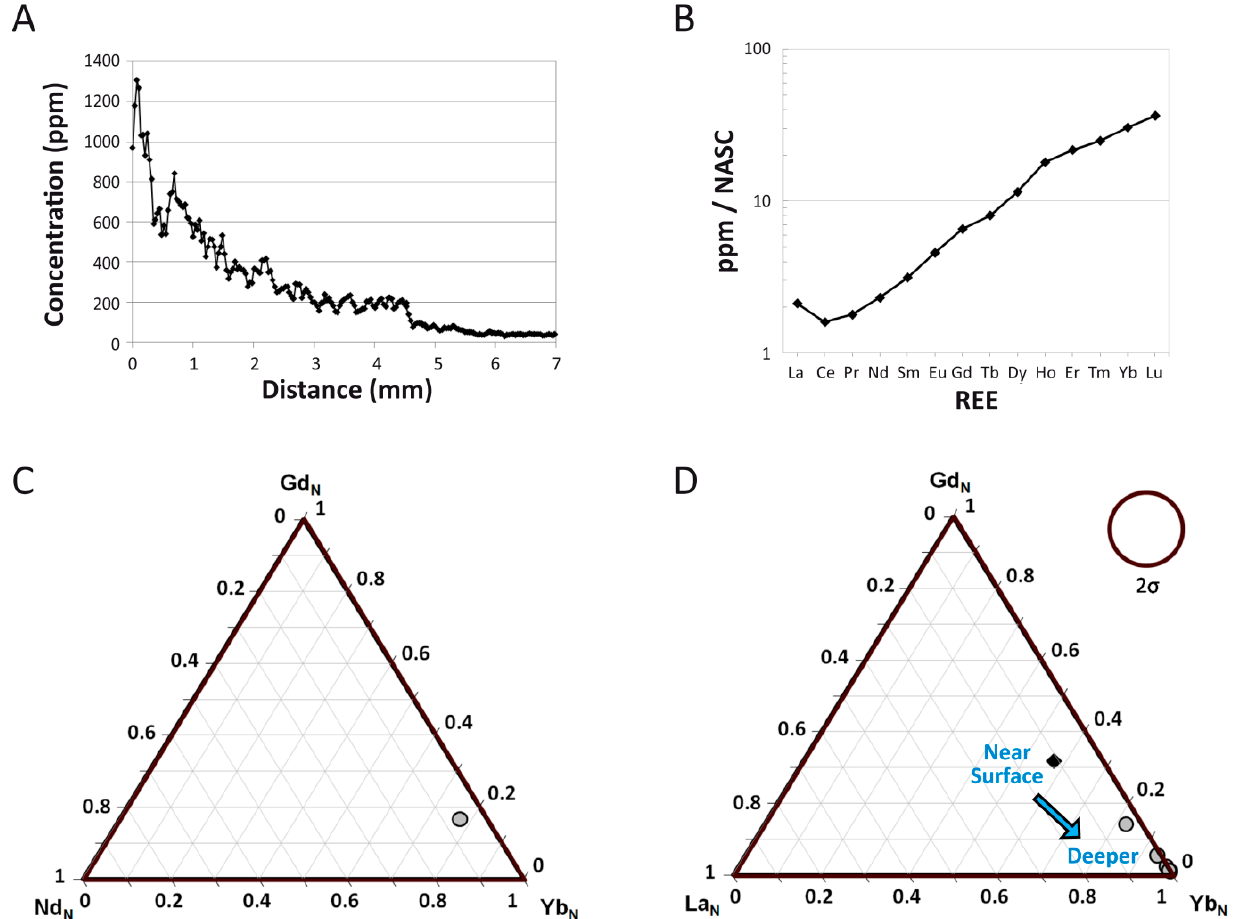
Figure 5. REE composition of the femur of MOR 1125. ( A ) Three-point moving average profile of La concentrations in the outermost 7 mm of the bone. ( B ) Average NASC-normalized REE composition of the fossil specimen as a whole. ( C,D ) Ternary diagrams of NASC-normalized REE. ( C ) Average composition of the bone. ( D ) REE compositions divided into data from each individual laser transect (~5 mm of data each). Compositional data from the transect that included the outer bone edge is denoted by a dark diamond; all other internal transect data are indicated by gray circles. The 2 σ circle represents two standard deviations based on ±5% relative standard deviation.